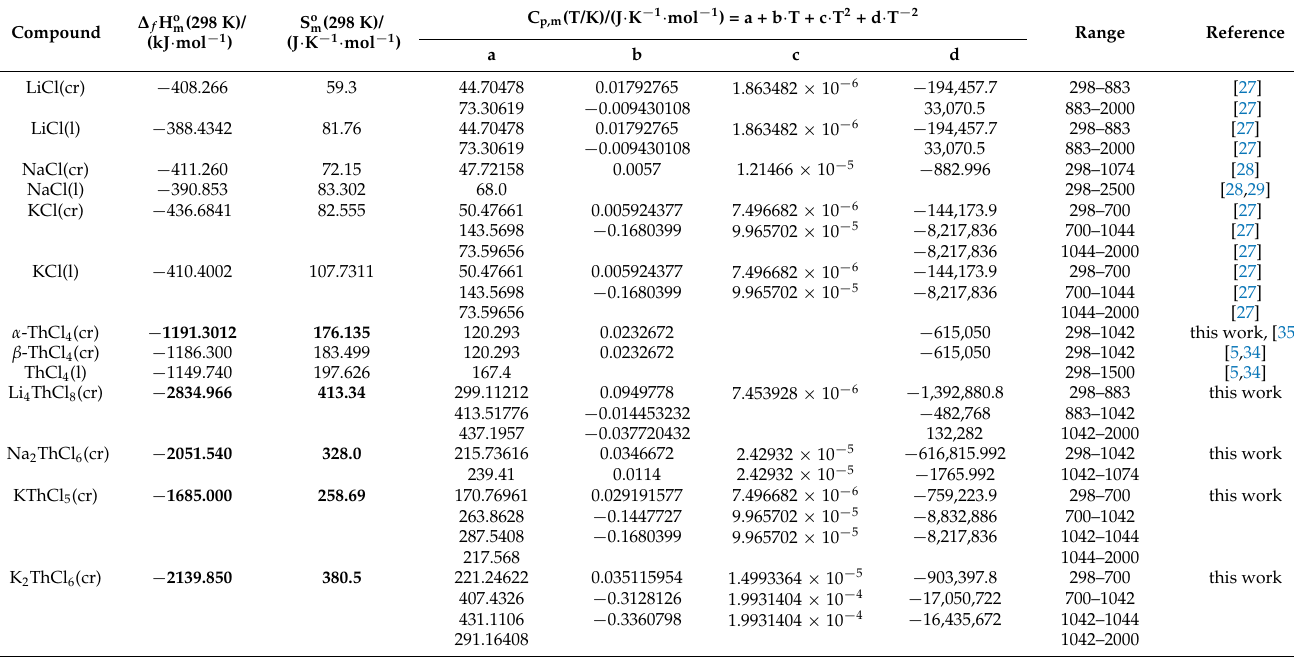
Table 2. Thermodynamic data for intermediate compounds used in this work for the phase diagram